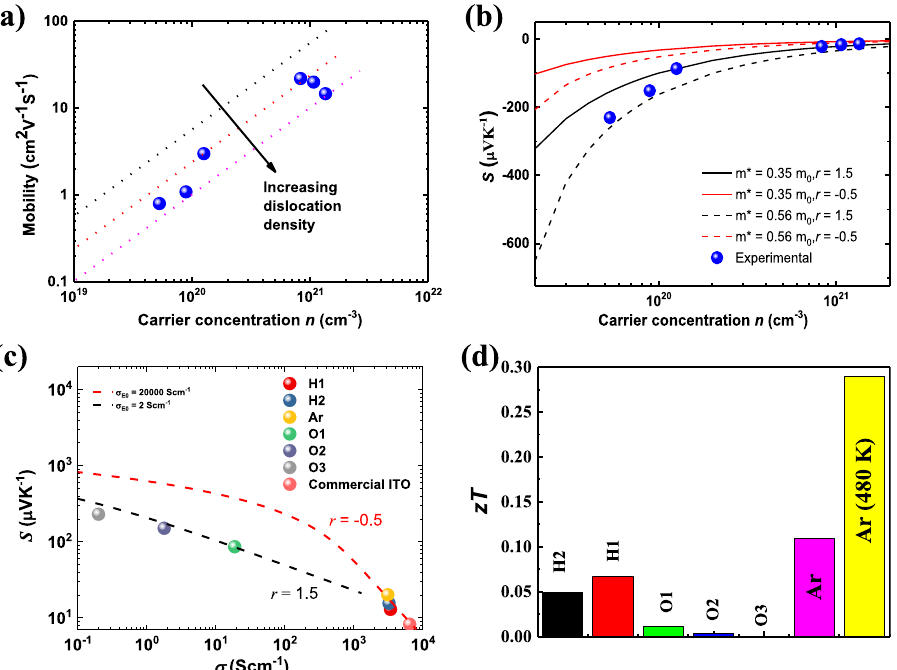
Fig. 4 Thermal and electrical properties of the ITO thin fi lm (130 nm) sputtered on polished glass. a Electron mobility vs. carrier concentration ( n ), b Seebeck coef fi cient ( S ) vs. carrier concentration ( n ), c Seebeck vs. electrical conductivity and d fi gure-of-merit ( zT ) for samples sputtered in different